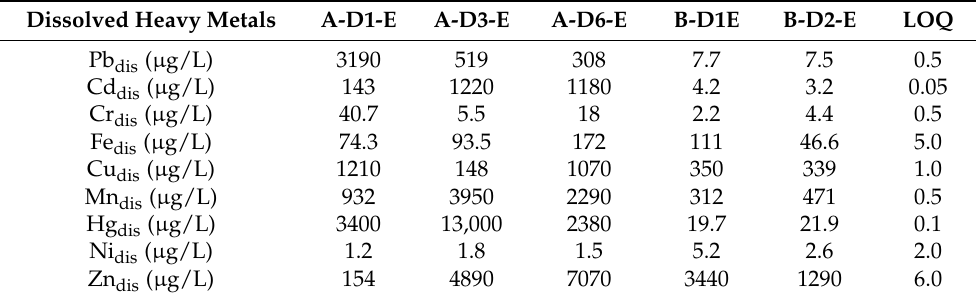
Table 7. Dissolved concentrations ( µ g/L eluate) of Pb, Cd, Cr, Fe, Cu, Mn, Hg, Ni and Zn of three dusts and the LOQ (in